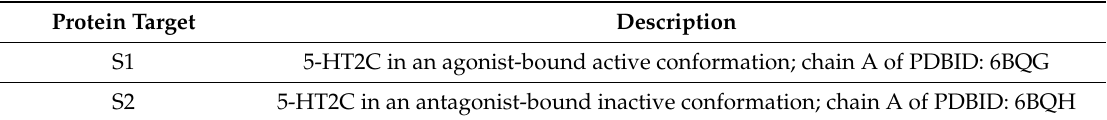
Table 1. Selected protein